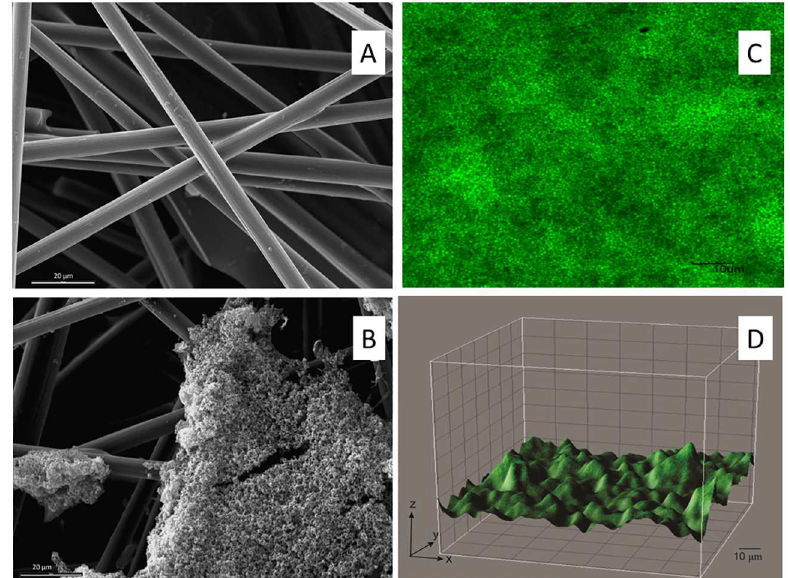
Fig 5. Microphotography of the working electrode used in the BES in order to understand the morphology of the biofilm formed by Dietzia sp. RNV-4 on carbon paper electrodes. (A) Electrode from a control experiment, 1000X, bar 20 μ m, by SEM. (B) Biofilm of Dietzia sp. RNV-4, 1000X, bar 20 μ m, by SEM. (C) Biofilm of Dietzia sp. RNV-4, 60X zoom 2.5, bar10 μ m, by CLSM. (D) Biofilm of Dietzia sp. RNV-4, 60X zoom 2.5, by confocalmicroscopy. XYZ images were processedusing the program Image